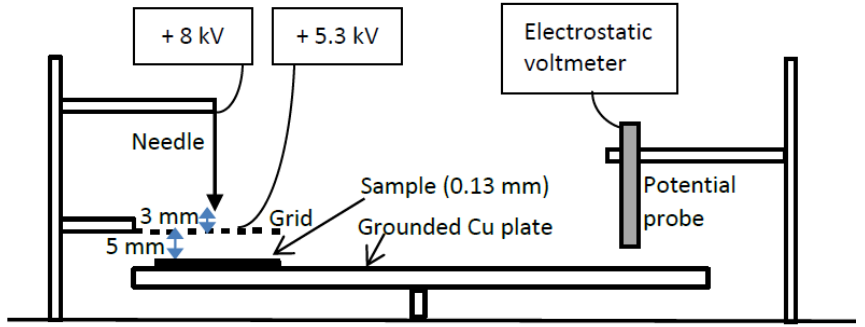
Figure 3. Sketch of the surface potential decay measurement setup.